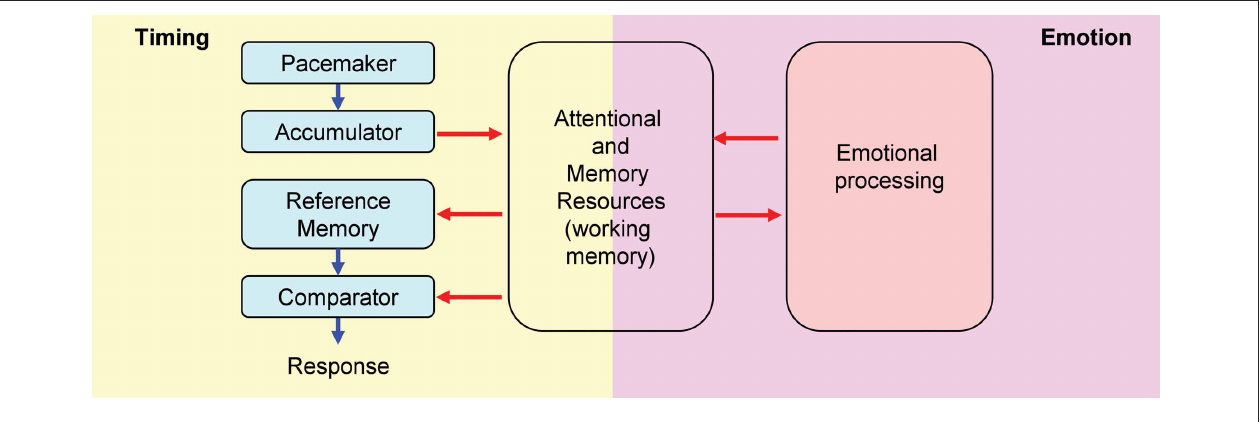
FIGURE 1 | Relative Time-Sharing model. The Relative Time-Sharing model assumes that timing and emotional processing are concurrent processes which share working memory and attentional resources. Task-irrelevant emotional events are assumed to take away working memory and attentional